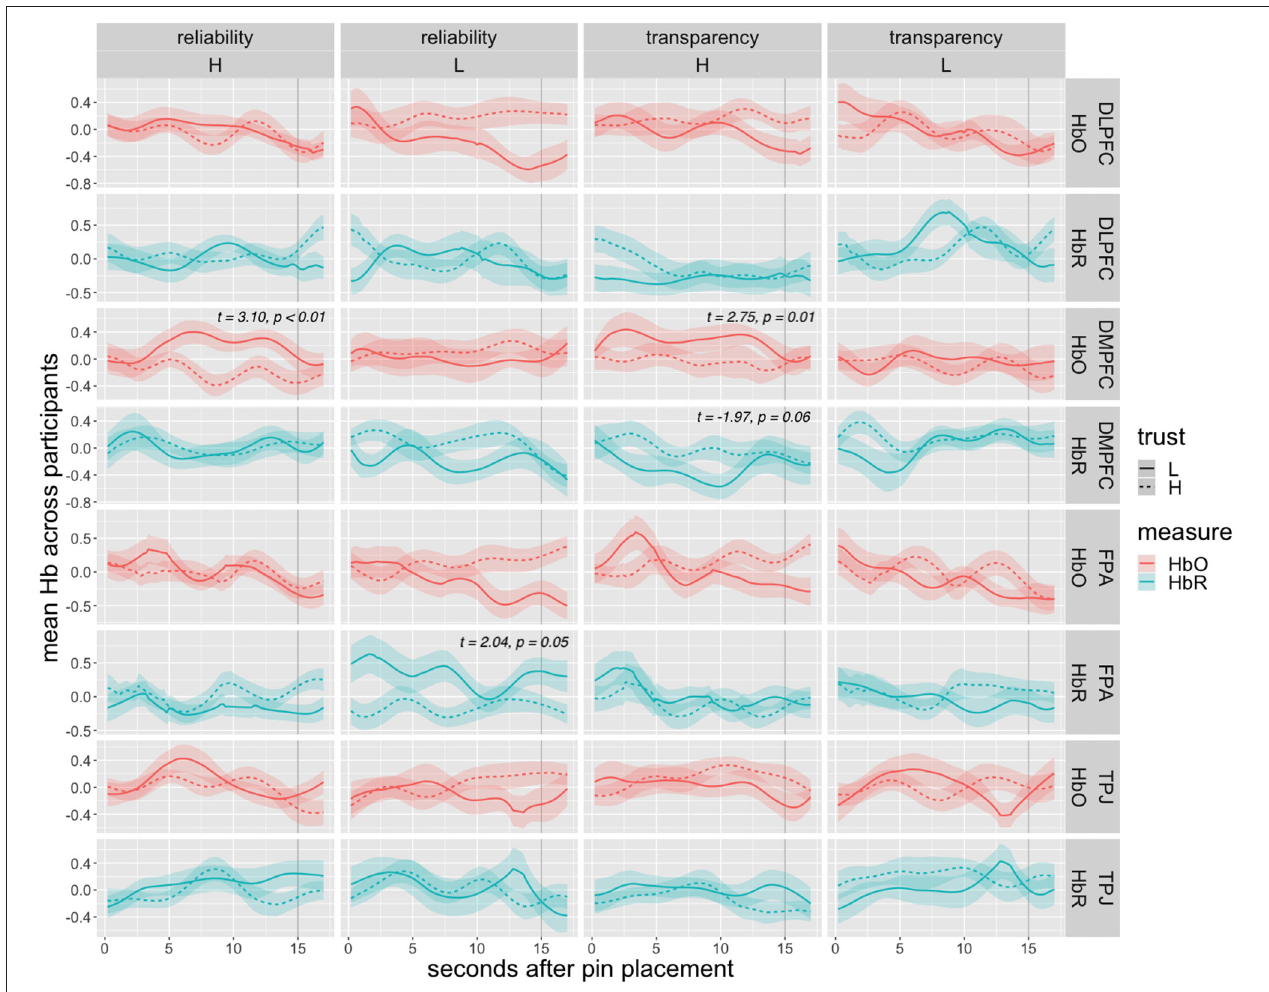
FIGURE 8 | Average HbO and HbR time series after agent pin placement and before the pin was moved (distrust). Dashed lines represent trust (pin never moved) cases, solid lines represent distrust (pin moved) cases, and ribbons represent standard error range. The gray vertical line marks the moment at which the pin was moved (for distrust cases) at 15s. Results of paired-sample t -test are given for significant or marginally significant